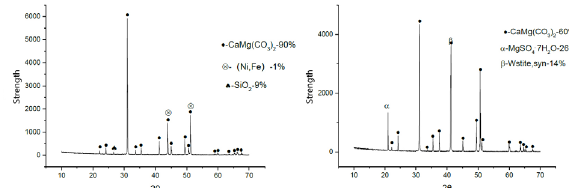
Figure 16 . XRD analysis results of two specimens. (Source: